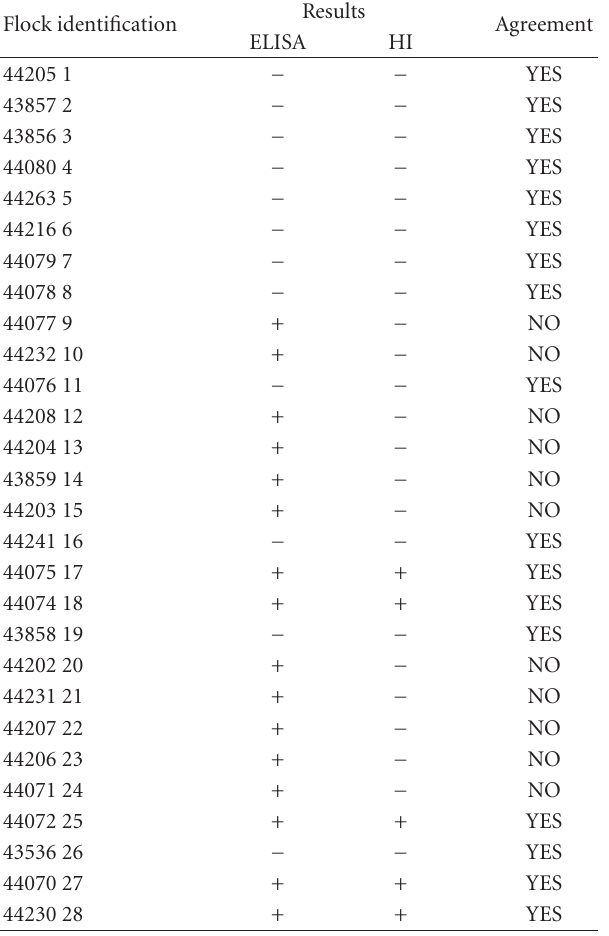
Table 3: Agreement between serological methods used for Mycoplasma synoviae diagnosis in commercial poultry breeder